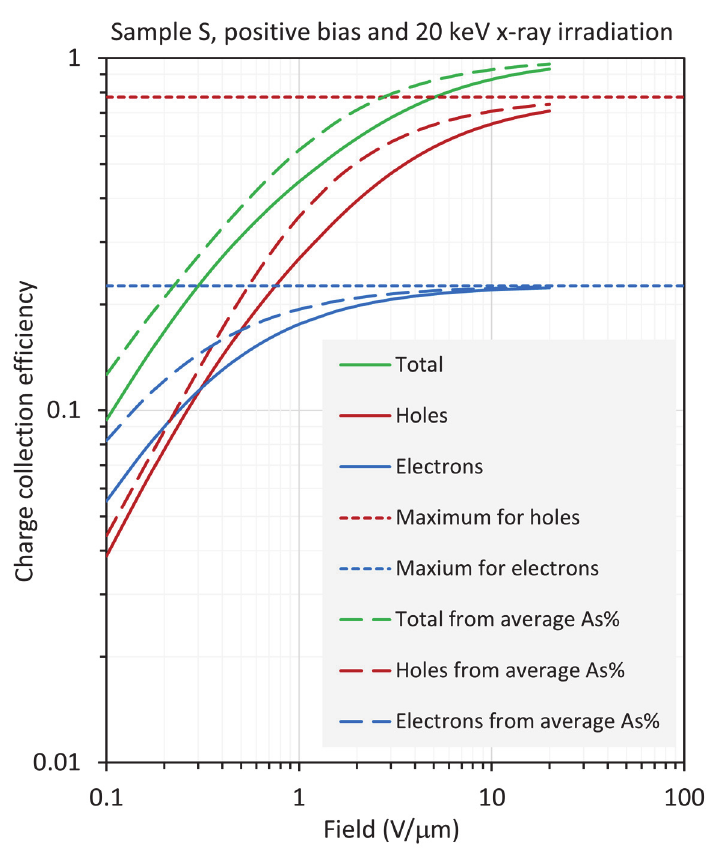
Figure 10. Log–log plot of the CE as a function of field for sample S (near worst case), biased positively and exposed to X-rays with a photon energy of 20 keV, so that δ / L